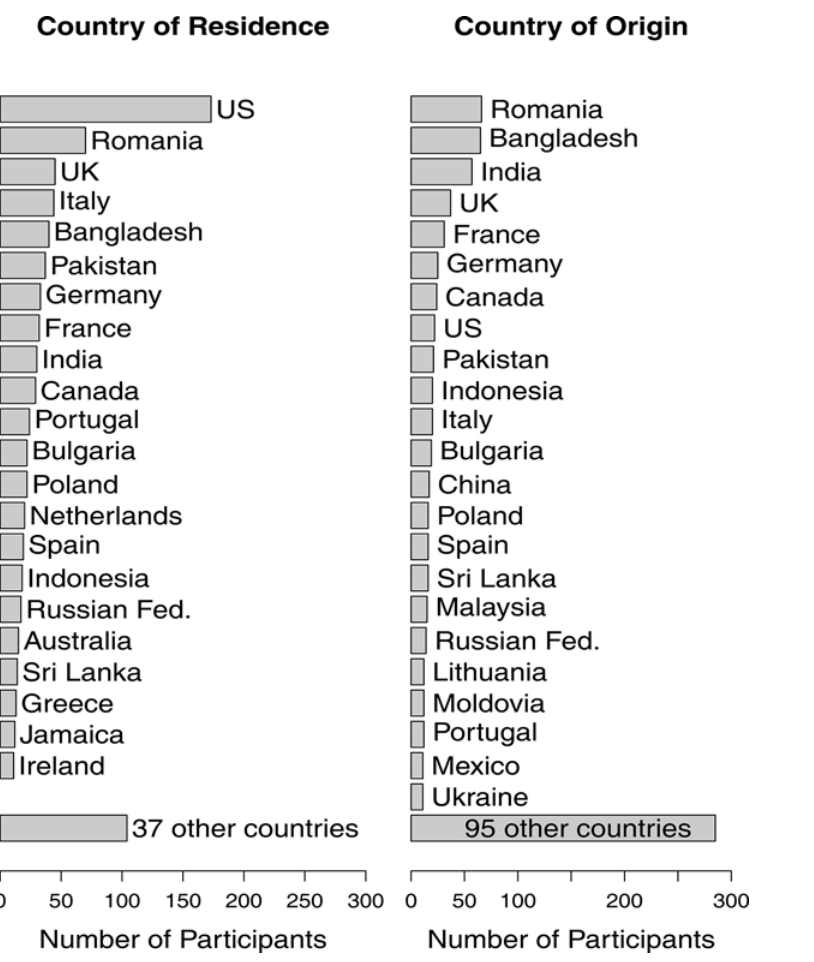
Fig 1. Number of participants living in, and stemming from, different